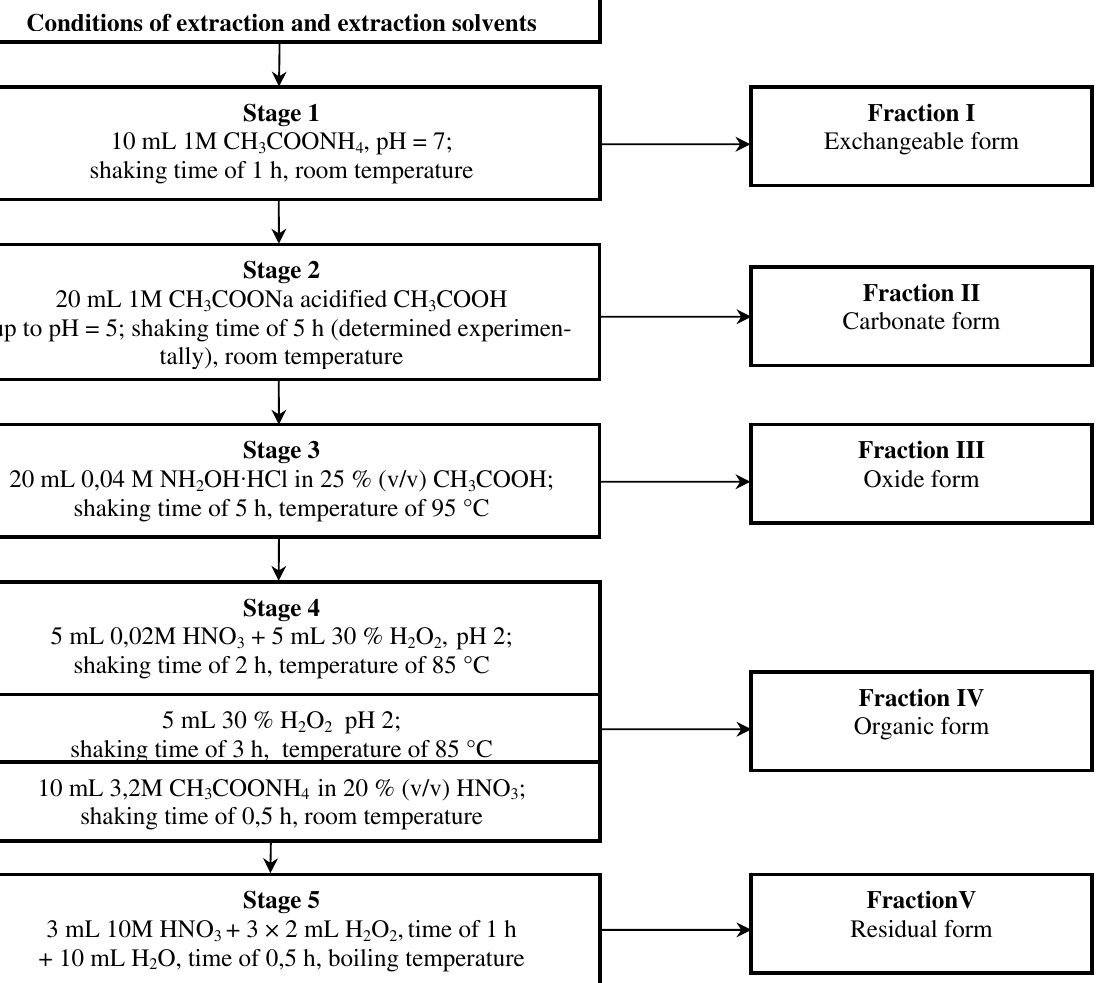
Fig 5. Scheme of fractionation of chromium soil samples from ecotonic zones